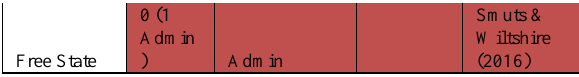
Table 3-1: Comparative representation of PHRA resources. Colour code is rated from worst (Red), to best (Green). Adapted from Smuts and Wiltshire (2016).